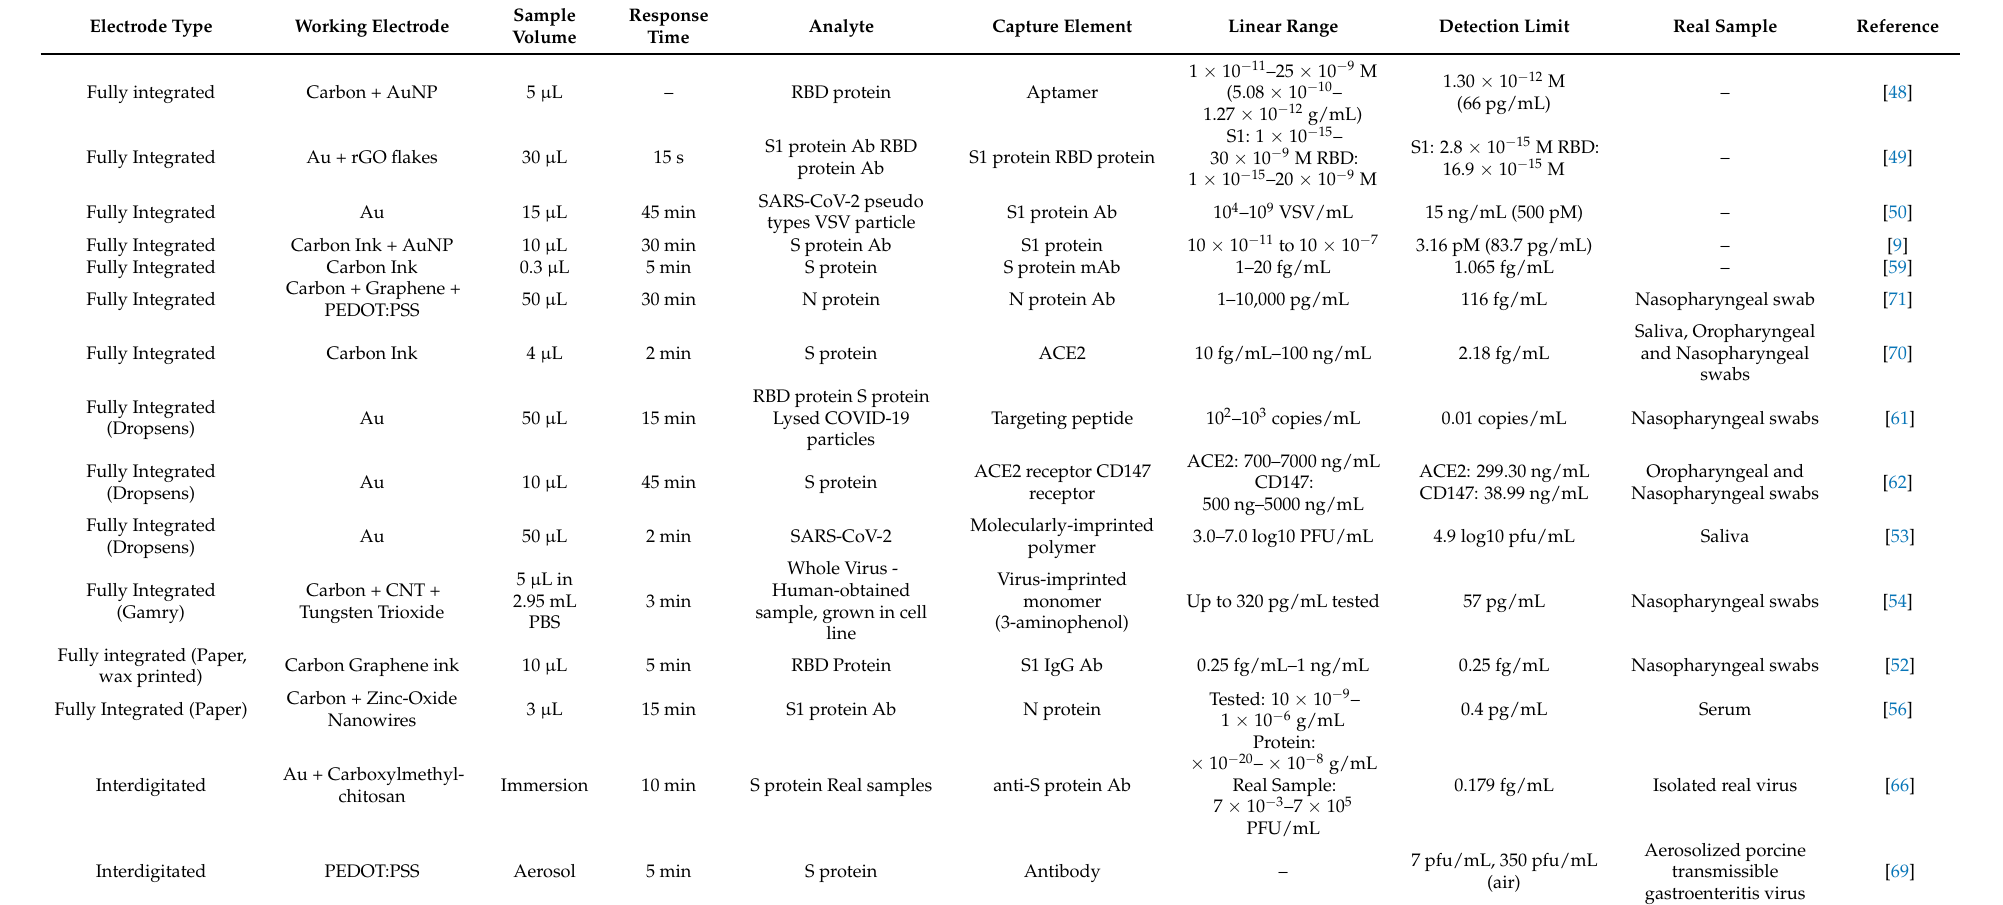
Table 2. Comparison of technical performance of the reviewed EIS-based sensors for diagnosis of